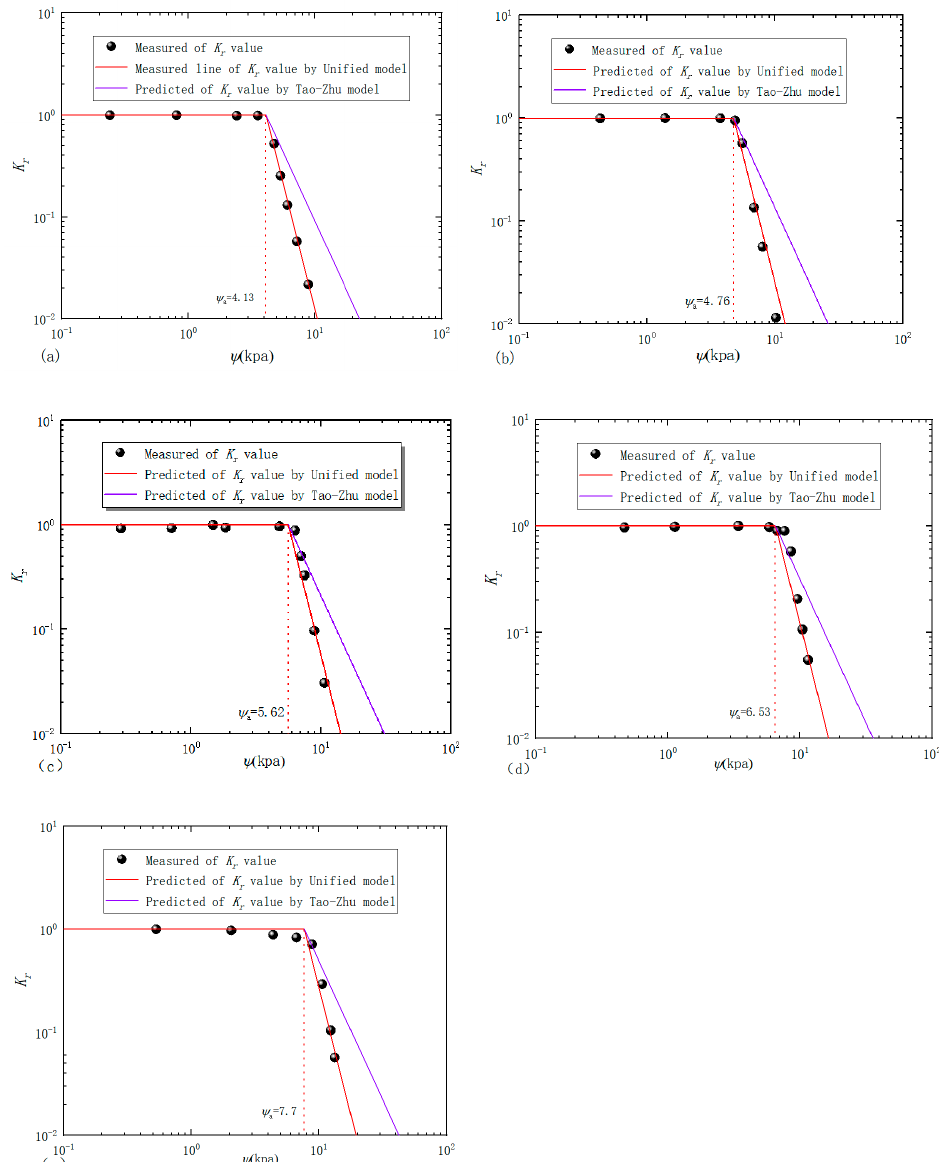
Figure 7. Comparison of Tao and Zhu models with different void ratios: ( a ) e = 1.012; ( b ) e = 0.916; ( c ) e = 0.815; ( d ) e = 0.733; ( e ) e = 0.653.